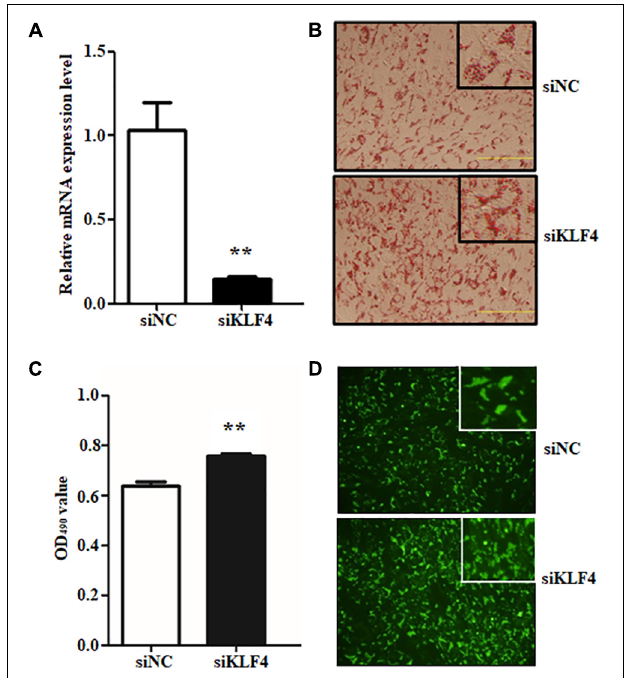
FIGURE 2 | Knockdown of KLF4 expression promotes goat intramuscular adipocyte adipogenic differentiation. (A) Knockdown efficiency detection of KLF4 at mRNA level mediated by siRNA. (B–D) Representative images ( × 400) of Bidipy staining and Oil Red O staining and extracting between control and siRNA-treatment intramuscular adipocytes. ** p < 0.01 versus negative control (siNC) groups. The Data are presented as mean values ± SD. Each experiment was performed at least in triplicate, producing consistent results. * p < 0.05, ** p <